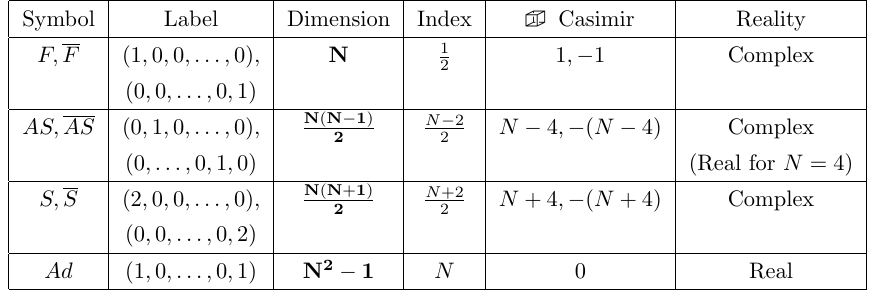
Table 1 . Various group theory data for SU( N ) representations associated with tensors with at most two indices. Here the label entry stands for the standard Dynkin label of the representation, and the symbol entry provides the shorthand symbol that will be employed for that representation throughout this article. The remaining entries list the dimension, Dynkin index ( a.k.a. quadratic Casimir), cubic Casimir, and the reality properties of each